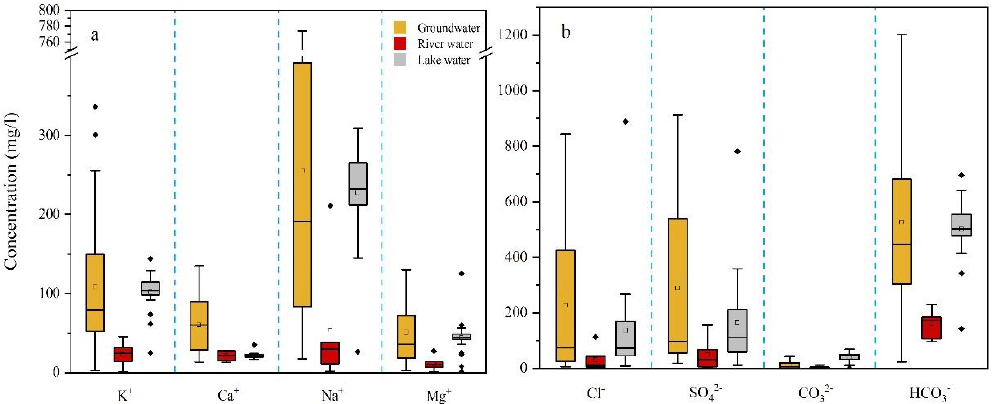
Figure 3. Cations ( a ) and anions ( b ) in the water in the Hulun Lake